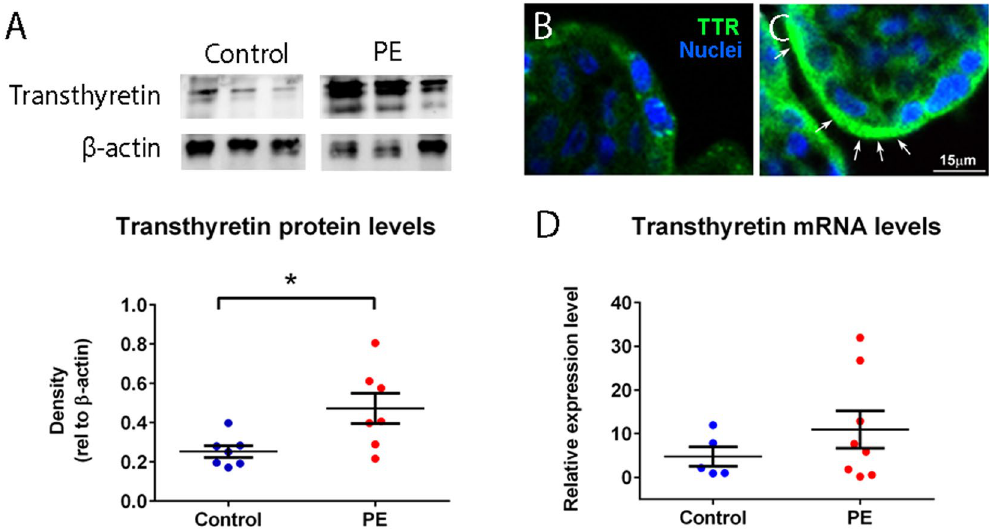
Figure 1. Transthyretin expression by preeclamptic placentae. Western blotting showed significantly higher levels of transthyretin in preeclamptic placentae compared to control placentae ( * p = 0.0212, n = 7, A ). Full-length blots are presented in Supplementary Figure 1. Immunofluorescent staining for transthyretin on placental sections from normotensive term ( B ) and preeclamptic pregnancies ( C ) showed higher levels of transthyretin in preeclamptic placentae. The granular staining of transthyretin are arrowed and can be seen most clearly in the control. Quantitative RT-PCR suggests that the mRNA levels of transthyretin were not different between preeclamptic and control placental explants (n = 8, D ). Mean and SEM are